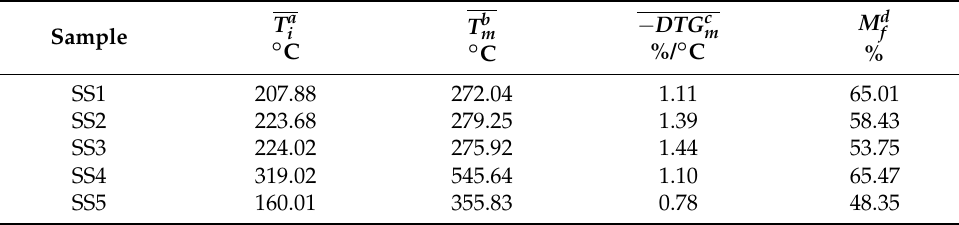
Table 2. Characteristic parameters for pyrolysis obtained at various heating rates.